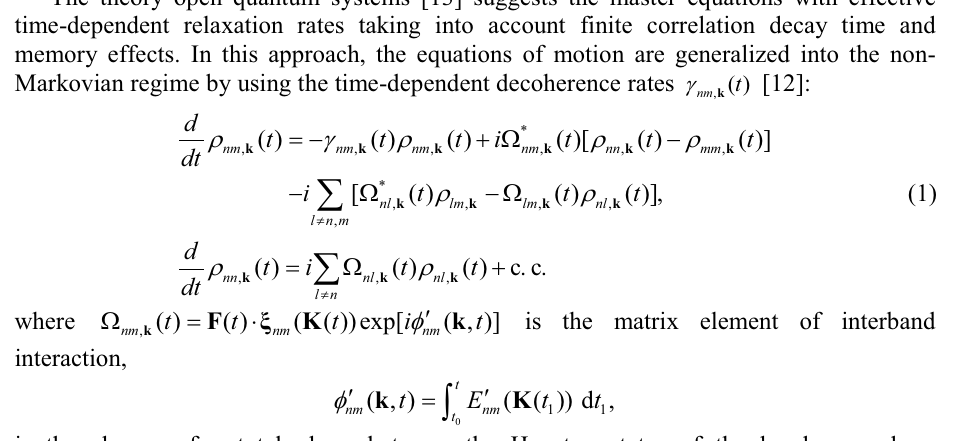
Table 4. Summary of approximations applicability for the bath of carrier correlations. Approximation Conditions Applicability Weak coupling (Born) Secular Instantaneous eigenbasis Partial